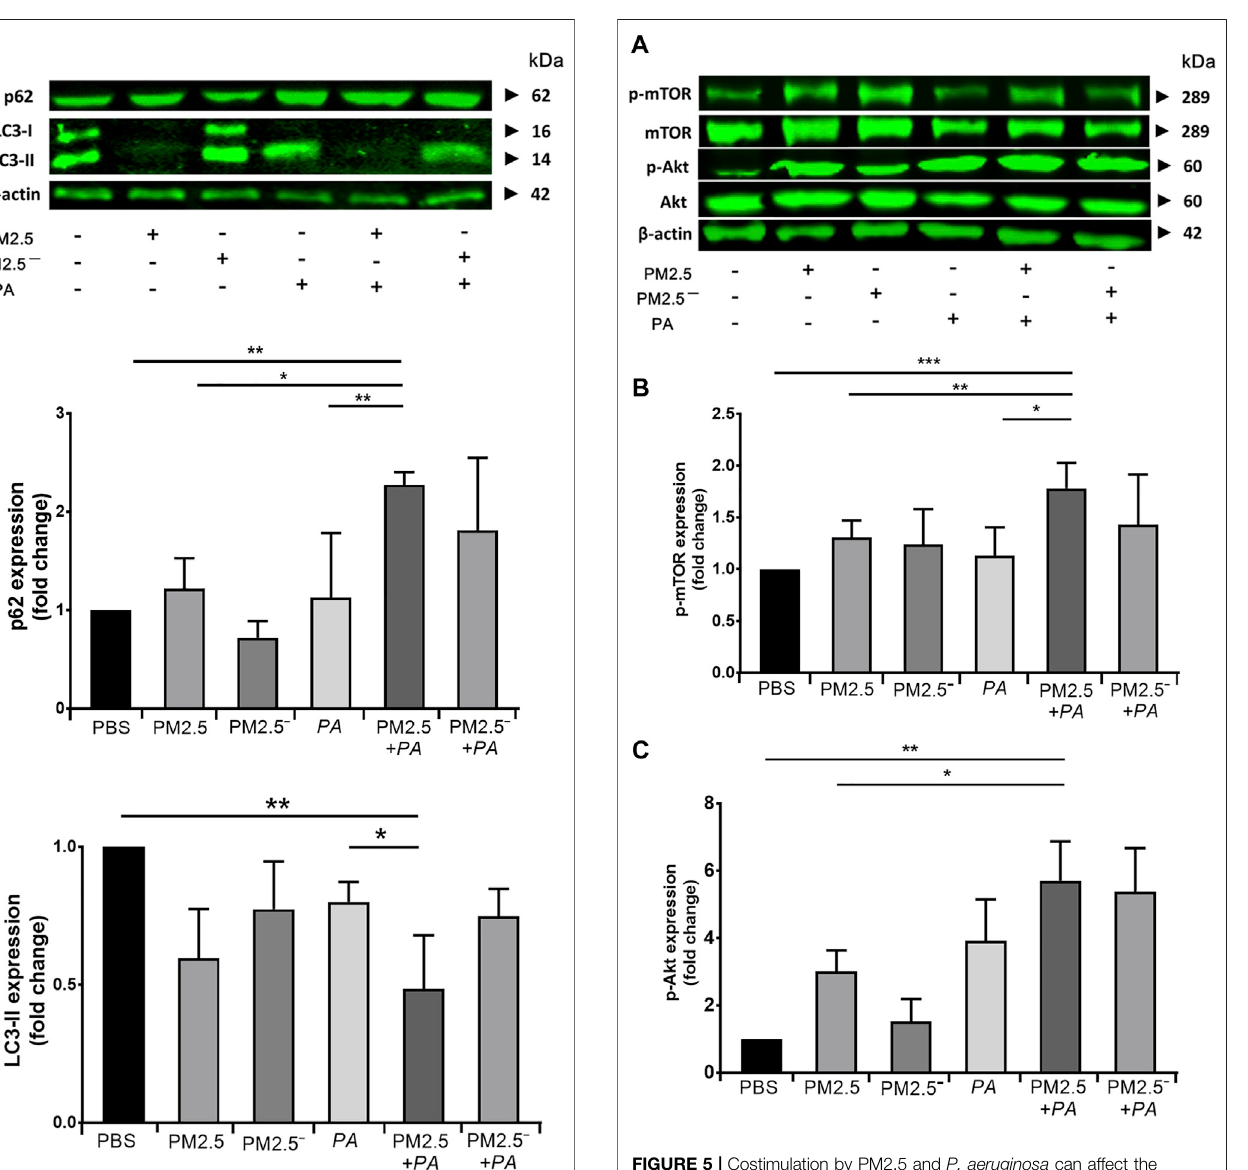
experimental groups, the changes in cells in the PM2.5 + PA group were the most substantial, and the cells in this group no longer had the morphology of normal cells but had a disordered micro fi lament structure. This outcome shows that PM2.5 and P. aeruginosa can destroy the skeletal structure of alveolar macrophages, and the effect is greatest when the two act synergistically.